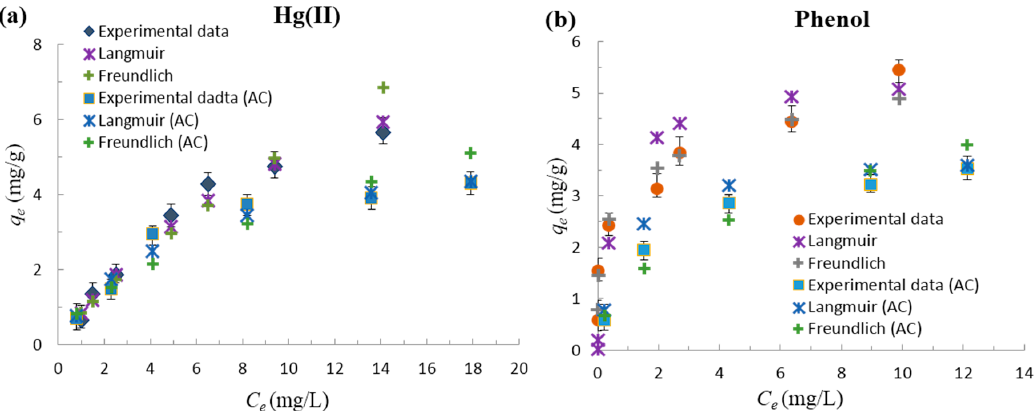
Figure 8. Plots of Langmuir and Freundlich adsorption isotherms for the removal of ( a ) Hg(II) and ( b ) phenol using functionalized-AC and bare AC. Table 2. Langmuir and Freundlich constants along with R 2 values obtained for the removal of Hg(II) and phenol using modified-AC.